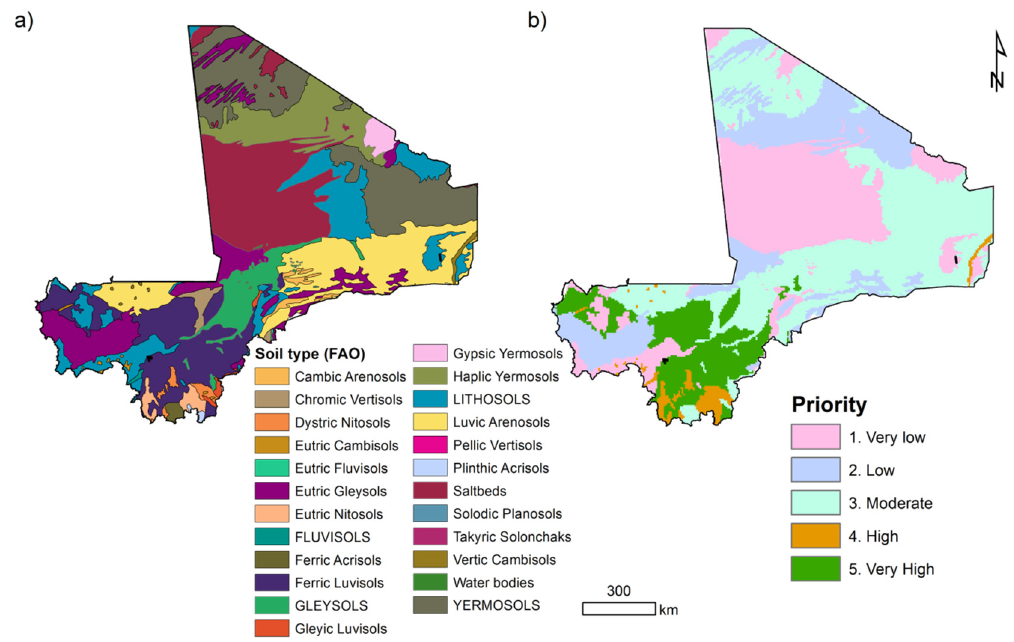
Figure 7. Soils of Mali (DSMW, FAO, 1995): ( a ) soil type; and ( b ) priority category.